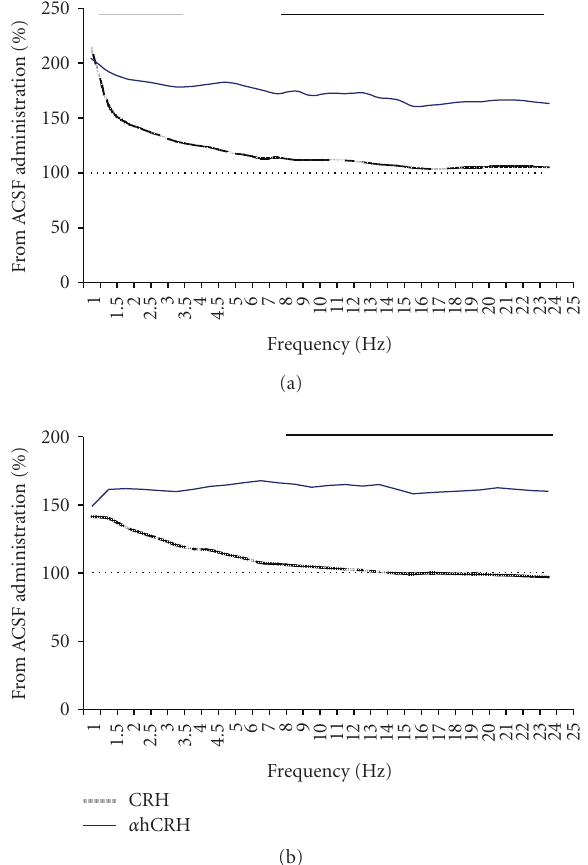
Figure 5: Spectral Power During Total NREM on the 2nd (a) and 3rd (b) Recovery Dark Phases . Results are expressed as percentage of ACSF-treated group, obtained from the mean power of each spectra band. ACSF, artificial cerebrospinal fluid; CRH, corticotrophin- releasing hormone; α hCRH, alpha helical CRH 9 − 41 . Grey line above graphics indicates di ff erences of α hCRH from ACSF and black ones, the di ff erence between the CRH and α hCRH treatments. Student’s t tests, P ≤ . 05.